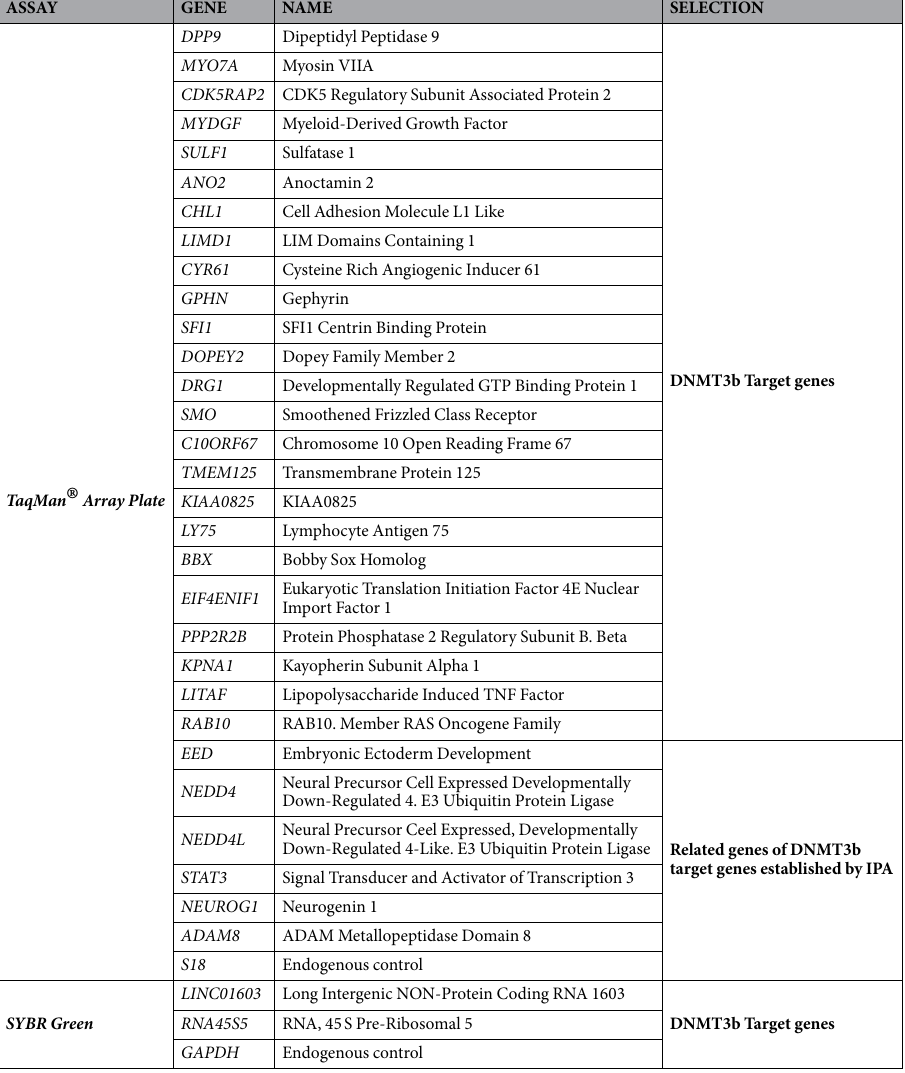
Table 3. Genes included in the differential expression study in human